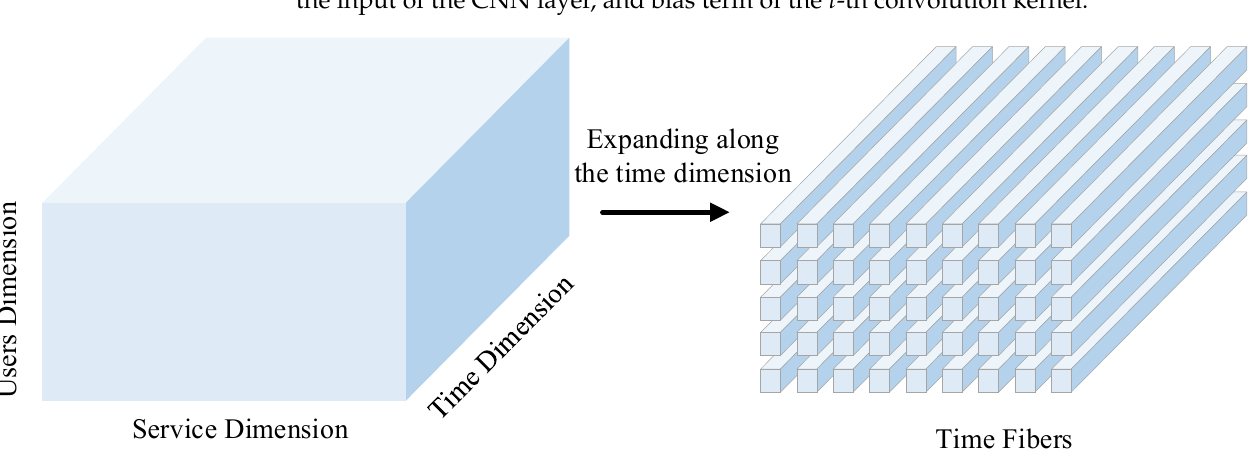
Figure 4. Schematic representation of tensor expansion into fiber patterns.